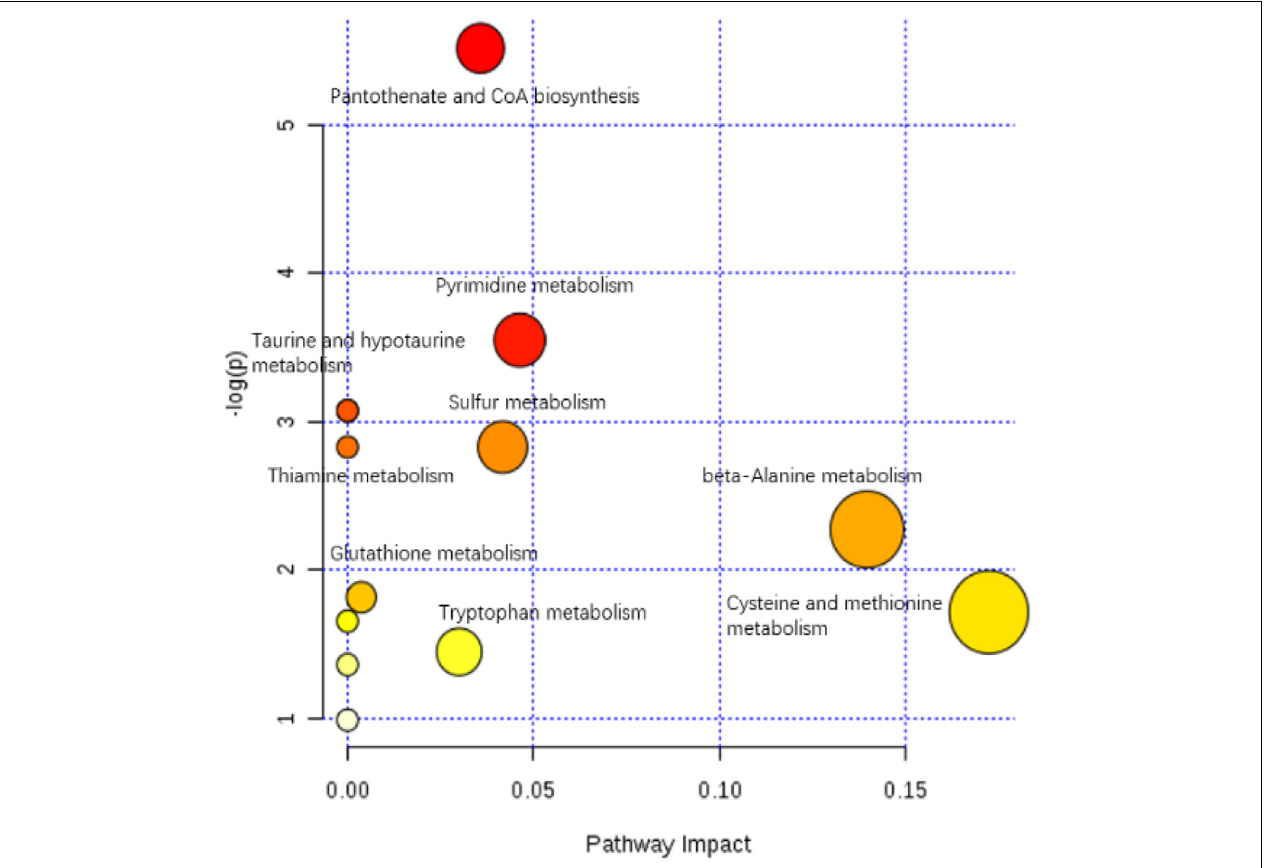
FIGURE 6 | The scatter plot of the metabolic pathway impact and enrichment for all matching significant metabolites in the liver of juvenile American eels of the OPC group in comparison with the HIS group. The colored points represent different metabolic pathways. The various color levels indicate different levels of significance of metabolic pathways from low (white) to high (red). The different sizes of each point are based on the pathway impact values. Moreover, the most relevant pathways’ names of points are labeled according to the significance and impact value of metabolic